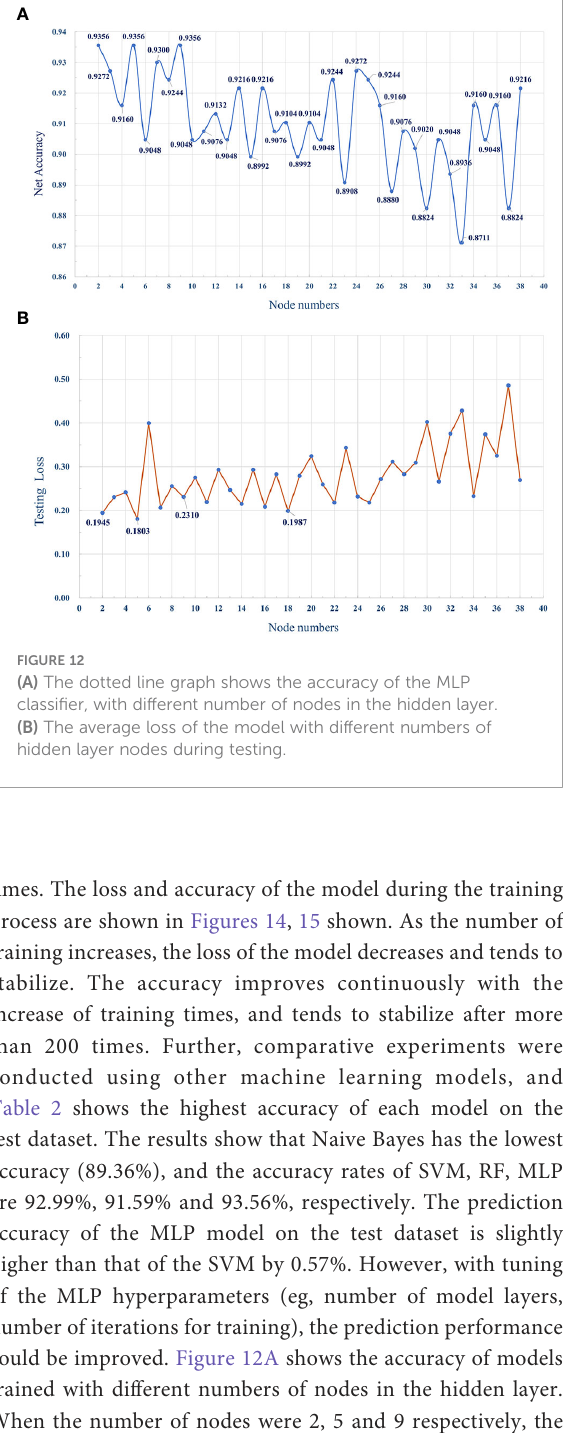
FIGURE 11 KEGG pathway enrichment for DEGs of ICS-A and ICS-B subtypes. The result shows the top 10 signi fi cantly enriched pathways.